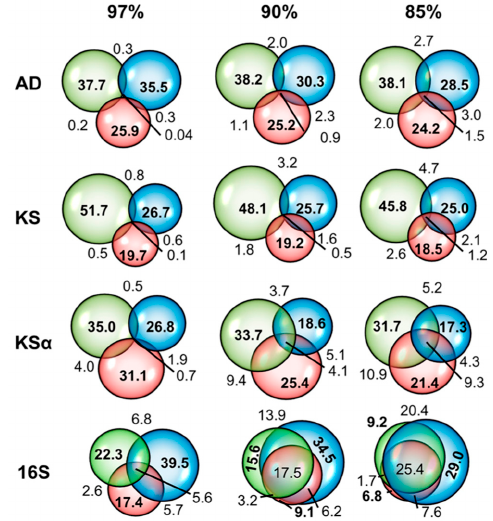
Figure 5. Overlap of sequences amplified from three soils from the desert sites in Arizona (green), Utah (blue) and California (red). Sequence are from non-ribosomal polypeptide (NRP) Adenylation